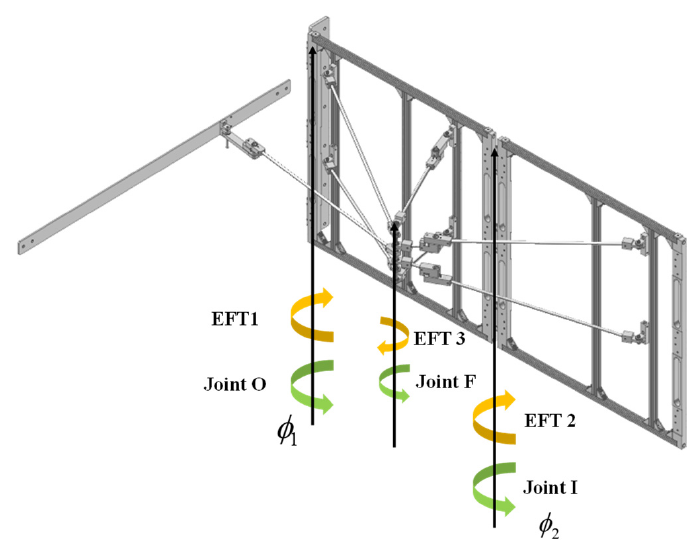
Figure 10. Definition of the equivalent friction